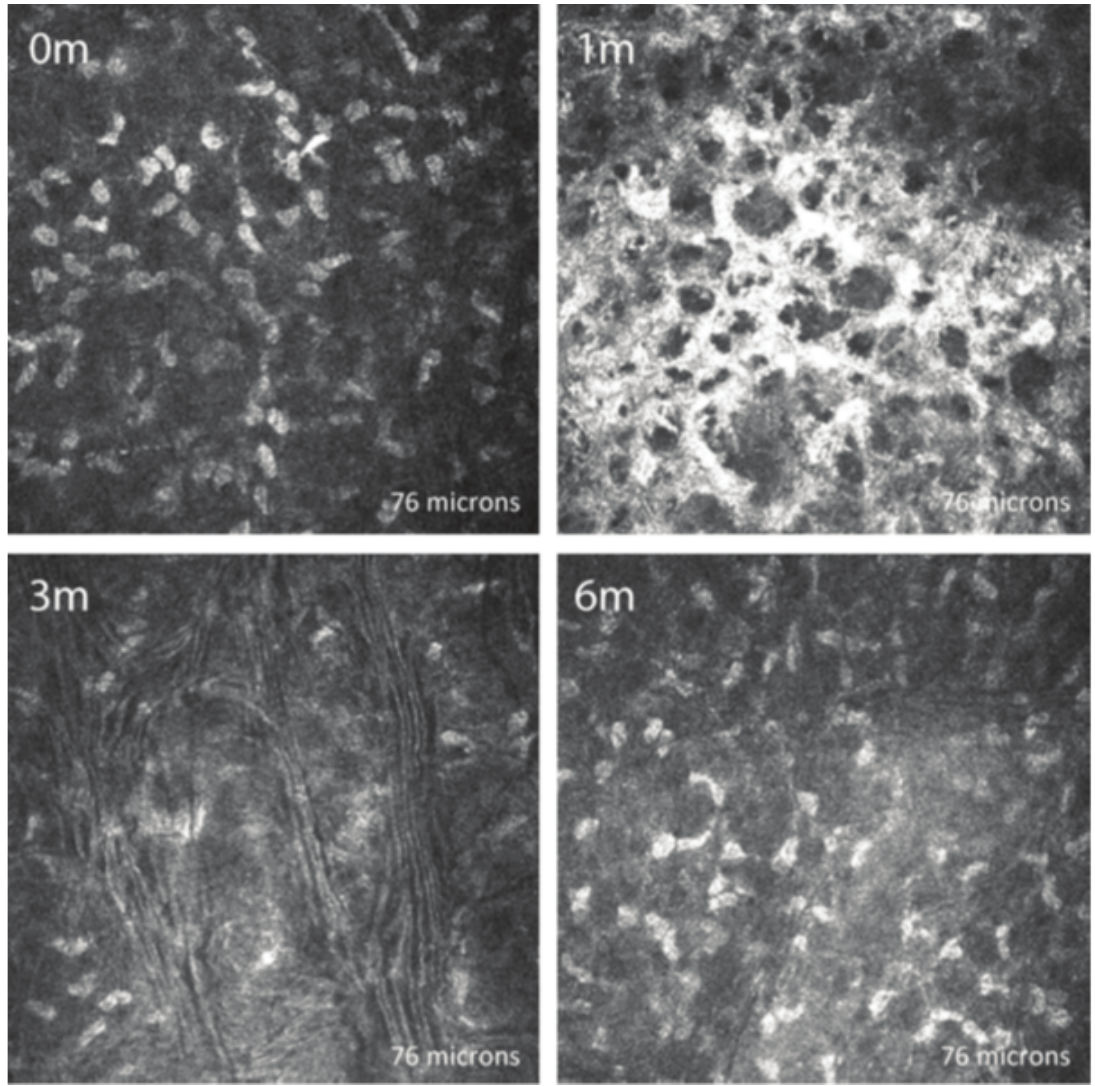
Figure 3. In vivo confocal microscopic images of the anterior stroma in a representative patient, taken at the same level at each visit. The scan shows normal keratocytes preoperatively (0 m). Post crosslinking, the anterior stroma showed hyper-reflective cytoplasm and extracellular lacunae in a honeycomb-like appearance with absence of keratocytes at one month (1 m) and gradual keratocyte regeneration at three months (3 m) and six months (6 m).